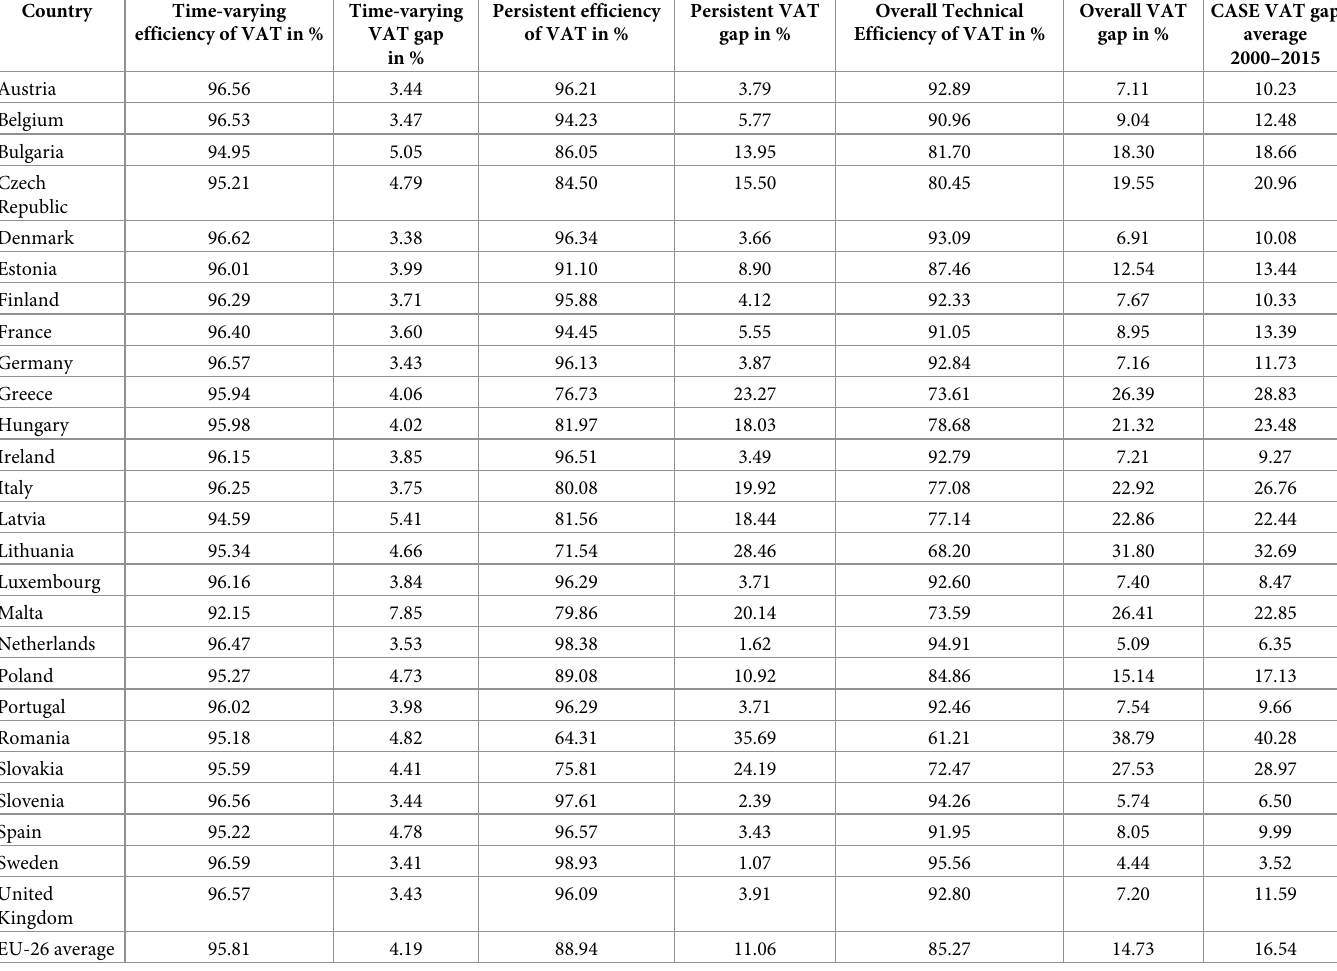
Table 6. Results of the STFM estimation of time-varying and persistent technical efficiency VAT and VAT gap using the model of Kumbhakar, Lien and Hardaker [8] for EU-26,